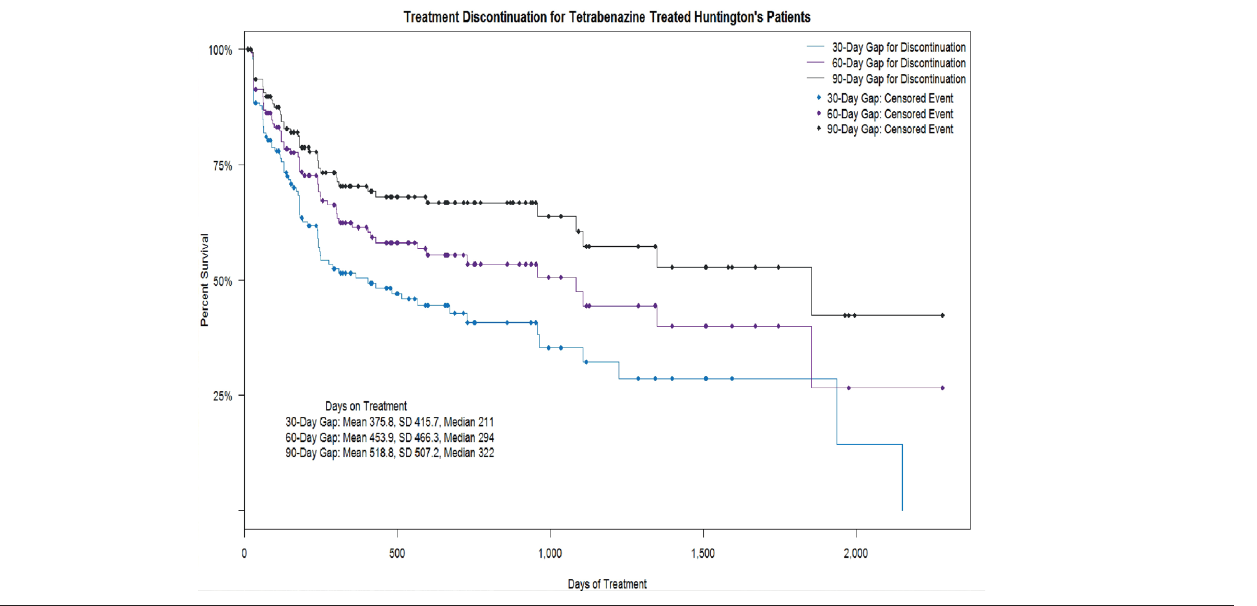
Mean and median time to discontinuation for HD chorea patients receiving tetrabenazine treatment for 30-, 60-, and 90-day gaps. HD: Huntington’s disease; SD: standard deviation